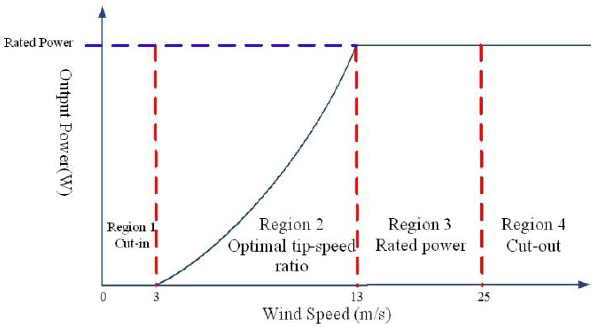
Figure 10. Four control regions in a wind turbine.